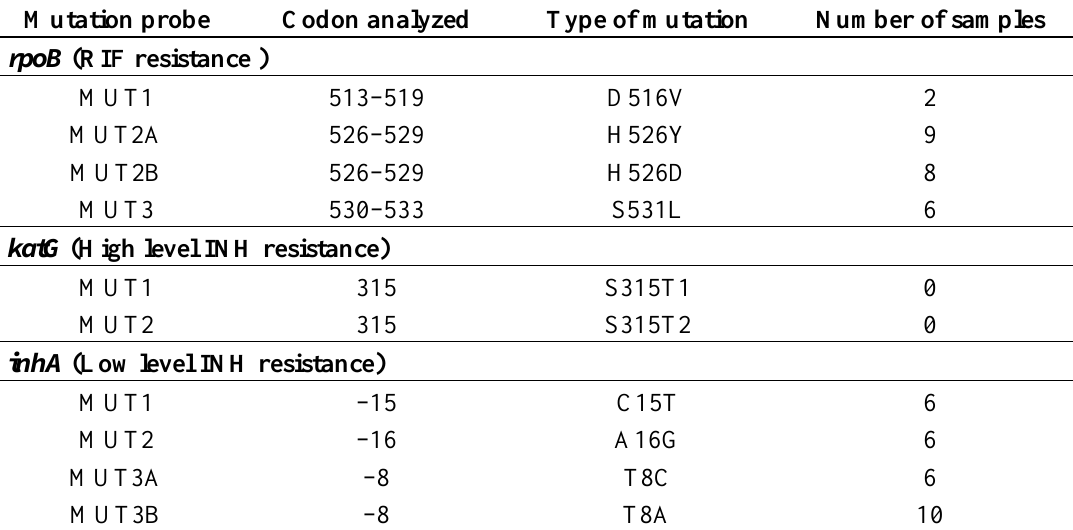
Table 3. Frequency of mutations conferring INH and/or RIF